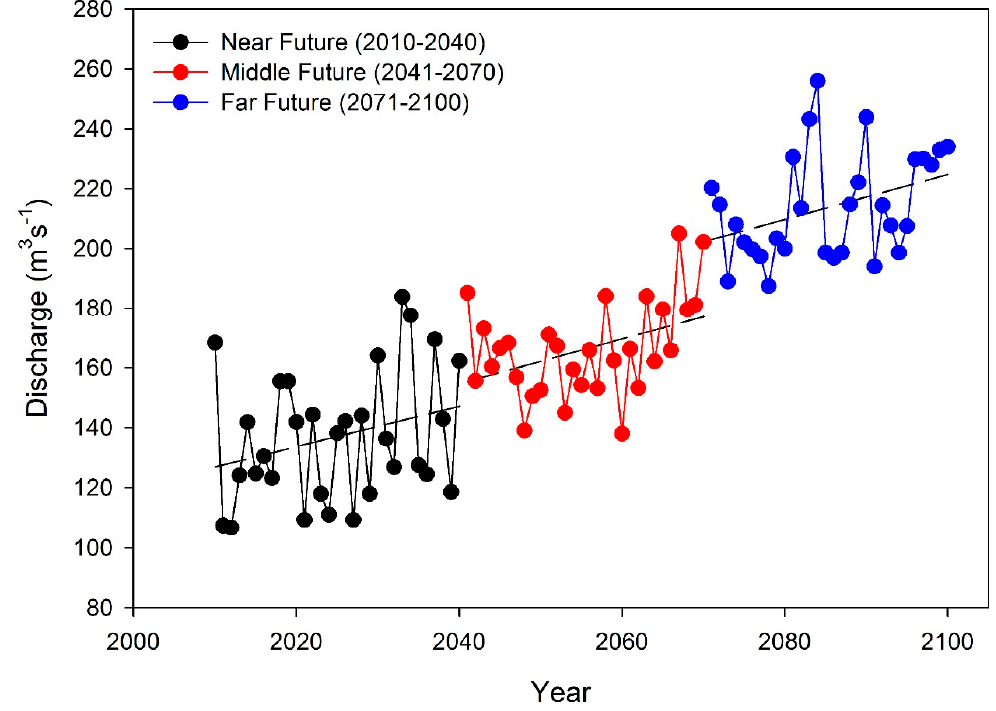
Figure 13. The trend of Yearly projected average discharge for near (2010–2040), middle (2041–2070), and future (2070–2100) under RCP8.5 climate change scenarios for the Astore River at the Doiyan gauge station.